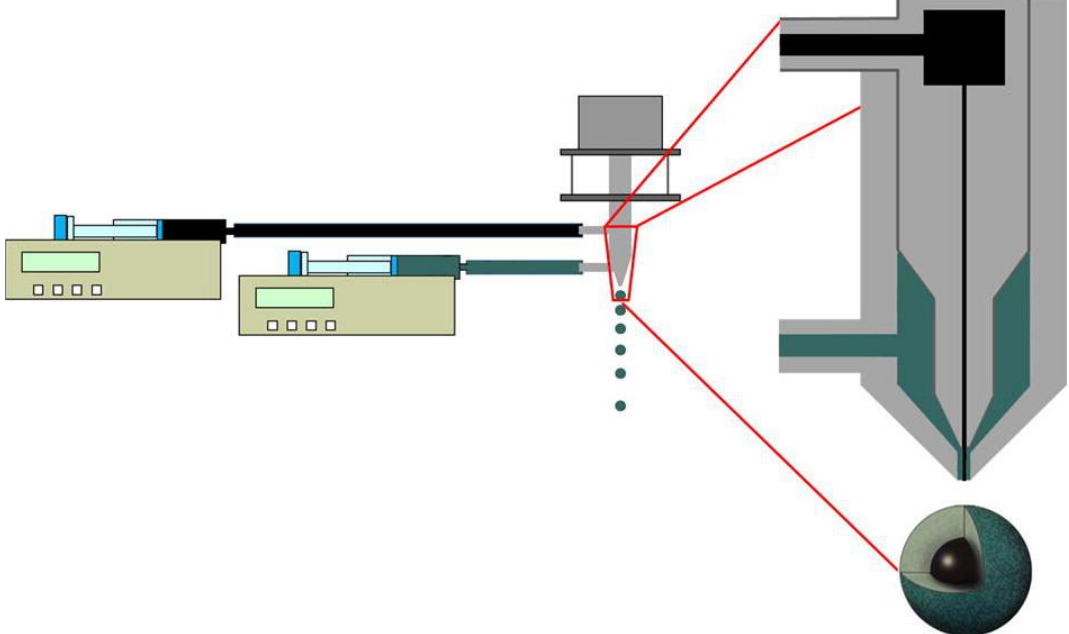
Figure 4. Schematic reproduction of prilling process in co-axial configuration. Reprinted from [43] with permission from Elsevier. Copyright (2014).